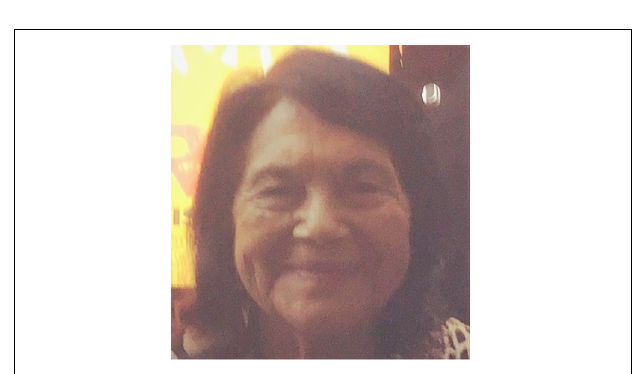
FIGURE 2 | Dolores Huerta. Attending a premiere of a film about her life in New York City in 2017.